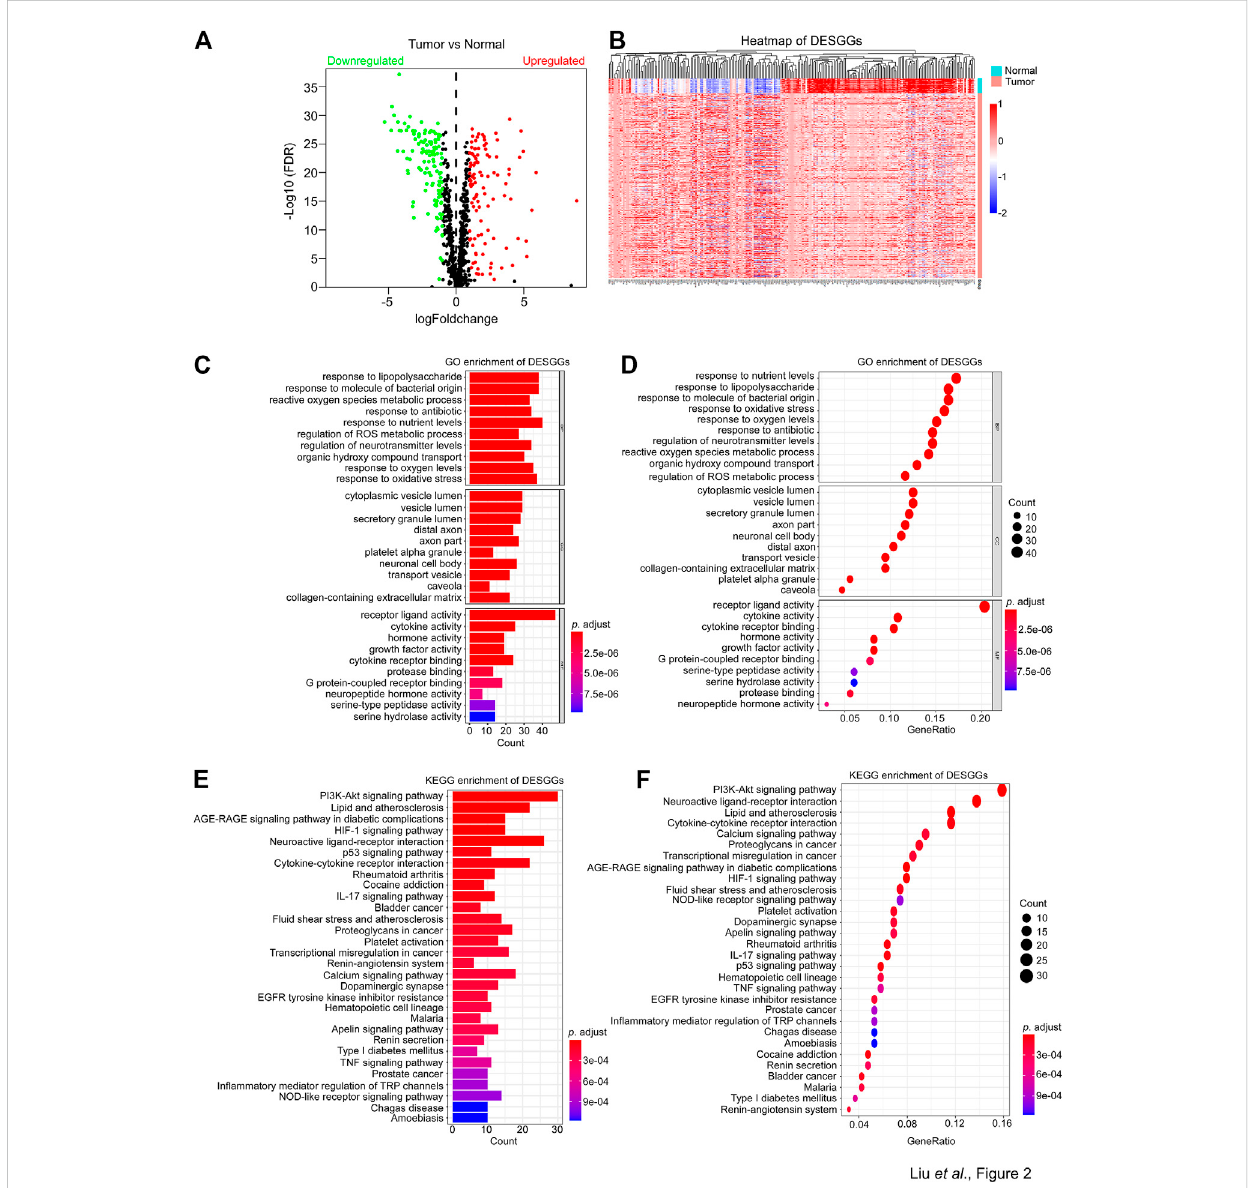
FIGURE 2 Identi fi cation of differently expressed SG genes and enrichment analysis. (A) 844 Stress granules-related genes were used to perform differentially expressed gene analyses between tumor and normal samples from the TCGA-CRC dataset. The 233 differentially expressed genes were identi fi ed with adjust p -value < 0.05 and |Log2FC| > 1. A volcano plot of the DESGGs was shown. Wilcoxon statistics were used to compare the different signi fi cance between tumor and normal samples. (B) The mRNA levels of 233 DESGGs were used to generate a heatmap in groups of tumor and normal tissues. (C – F) The 233 DESGGs were used for Gene Ontology (GO) or (E,F) Kyoto Encyclopedia of Genes and Genomes (KEGG) enrichment